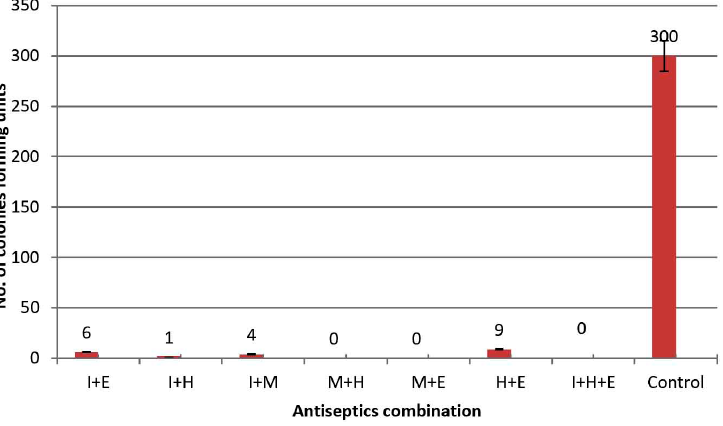
LSD(P ≤ 0.05)=6.176 Fig. 5. Number of colonies forming units (CFU) on agar plate resulted from growth of B. thuringiensis spores after spreads 0.1 ml of spore suspension from surgical tools sterilized by combination of different sterilizing solutions.I, povidone iodine; E, Ethanol; H, Chlorhexidine; M,